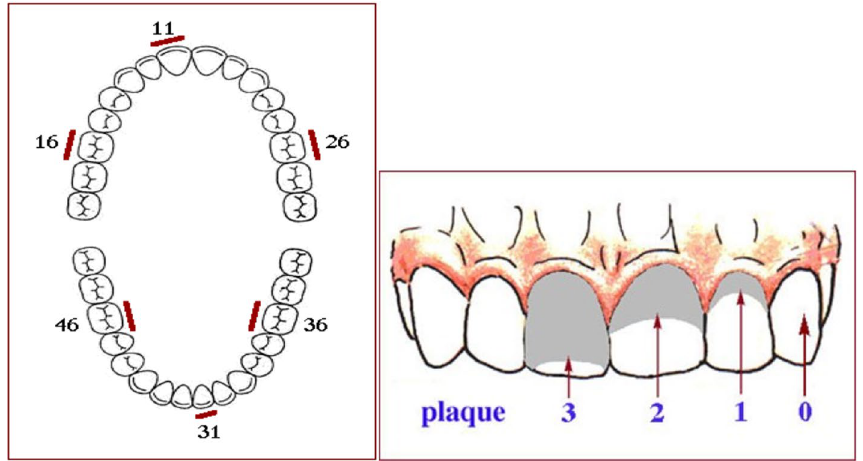
Figure 1. Malmo University oral healthy database.